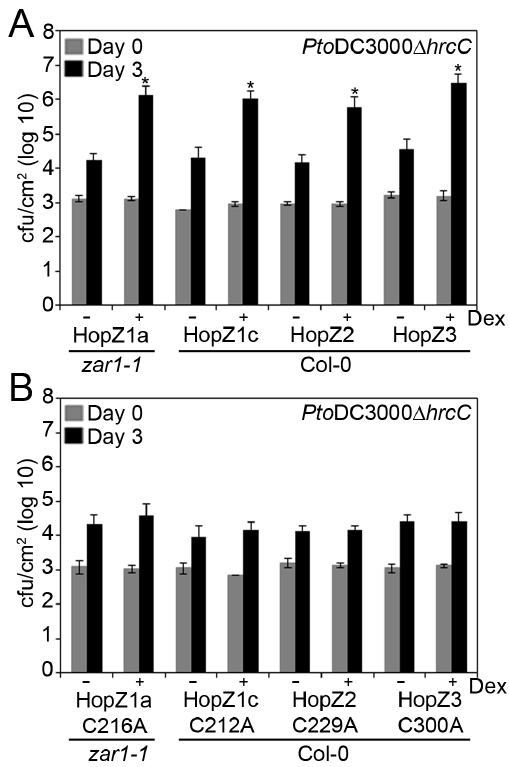
Fig. 3. HopZ family members suppress PTI. (A) Pto DC3000 D hrcC was pressure infiltrated at 10 5 cfu/mL into transgenic HopZ1a (line 2D), HopZ1c (line 21A), HopZ2 (line 12B) or HopZ3 (line 21J). The HopZ1a transgenic line was generated in an Arabidopsis zar1-1 background to focus on virulence rather than avirulence response, while the other members of the HopZ family were generated in Arabidopsis Col-0. Bacterial counts were determined one hour post-infection (Day 0) and 3 days post-infection (Day 3). Transgenic HopZ lines were induced by spraying with 30 m M dexamethasone or water 1 hour post-infiltration. Two-tailed homoschedastic t-tests were performed to test for significant differences. Within a plant genotype, dexamethasone-induced plants were compared to non-induced plants and significant differences are indicated by an asterisk (* P , 0.01). Error bars indicate the standard deviation from the mean of 10 samples. Growth assays were performed at least 3 times. (B) Transgenic HopZ1a C/A (line 1G), HopZ1c C/A (line 4F) and HopZ3 C/A (line 13C) lines were tested as in part A.,Transgenic HopZ2 C/A (line 4G) line was sprayed 24 hours pre-infiltration as its expression level was lower than the other lines.